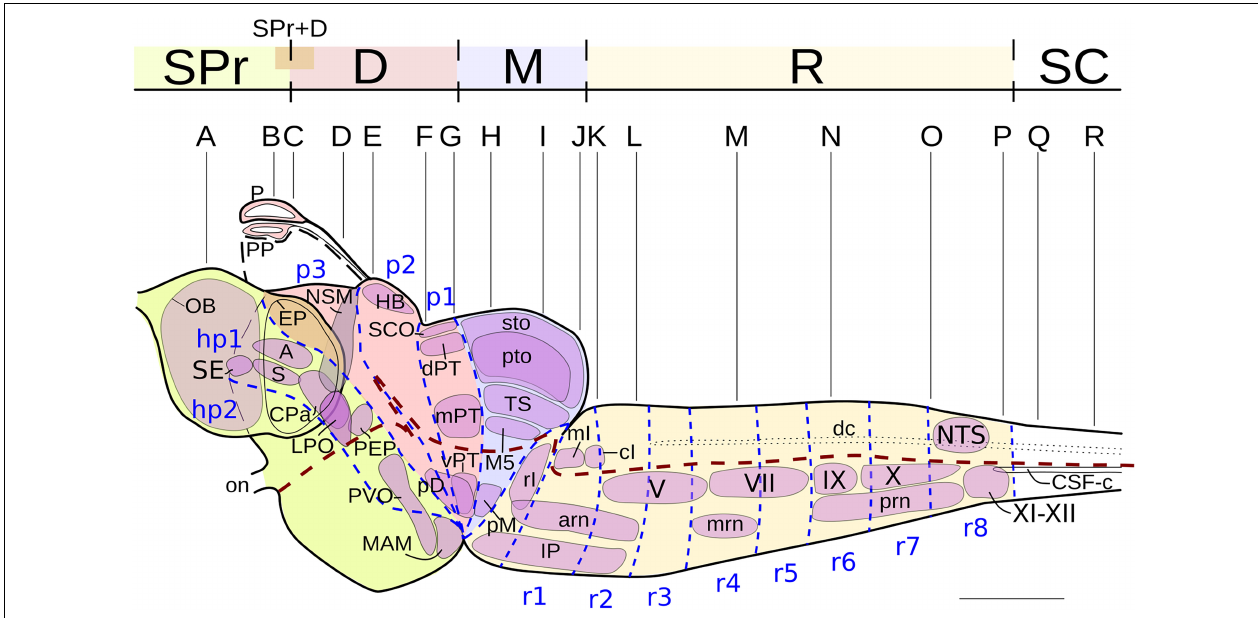
FIGURE 1 | Lateral view of the brain and rostralmost spinal cord of the lamprey Lampetra fluviatilis , showing the NADPH-d labeled nuclei (thin continuous black lines). The dashed blue lines mark putative neuromeric subdivisions (modified from Pombal et al., 2001, 2009; Murakami et al., 2004) and the thick dashed brown line represents the alar-basal boundary. The levels of the transverse sections shown in Figure 2 are also indicated. Rostral direction is oriented to the left. For abbreviations, see list. Scale bar = 1